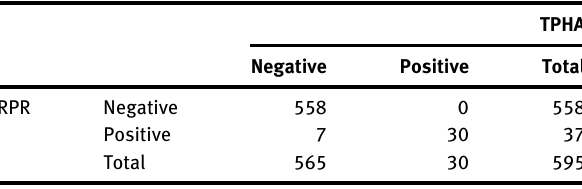
Table  : Comparison of TPHA and rapid plasma reagin (RPR) test